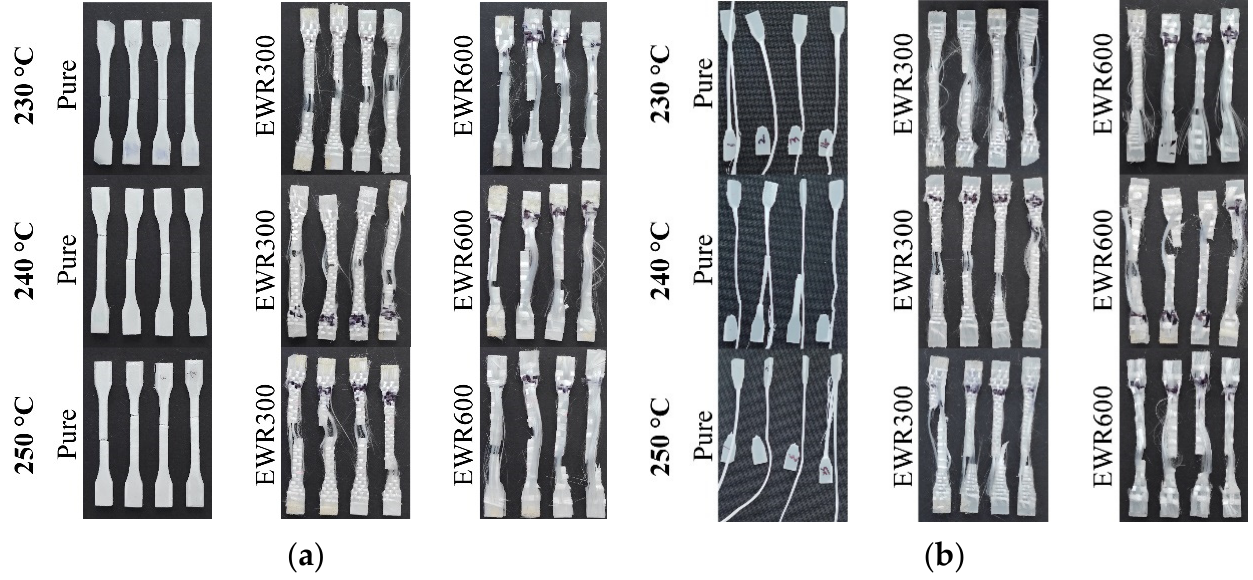
Figure 7. Pictures of the foamed ( a ) and unfoamed ( b ) samples after tensile testing.